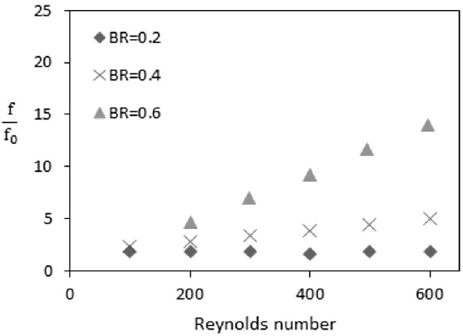
Fig. 4 Validation of the results associated with Nusselt number obtained for present work with that Bergman and Incropera [25]